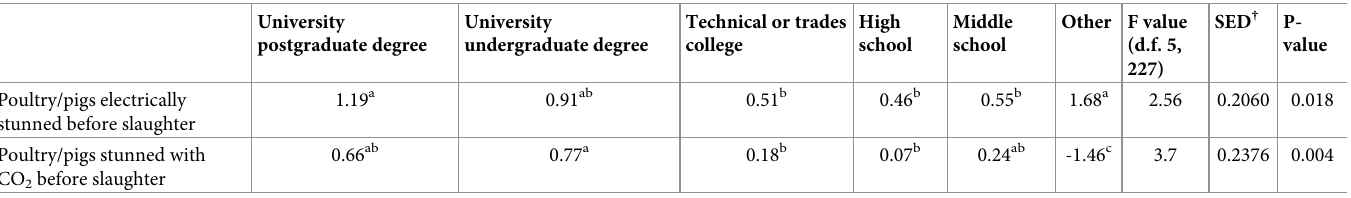
Table 6. Significant (P < 0.05) effects of level of education of stakeholders, who were stakeholders in the animal transportation and slaughter sectors, on the mean utility values of issues, which measure the perceived importance of different issues for animal welfare. High values indicate high